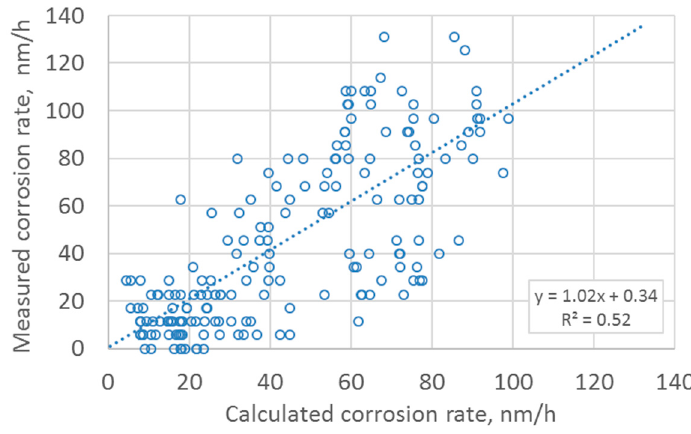
Figure 16. Comparison of the corrosion rate obtained based on calculations and measurements.